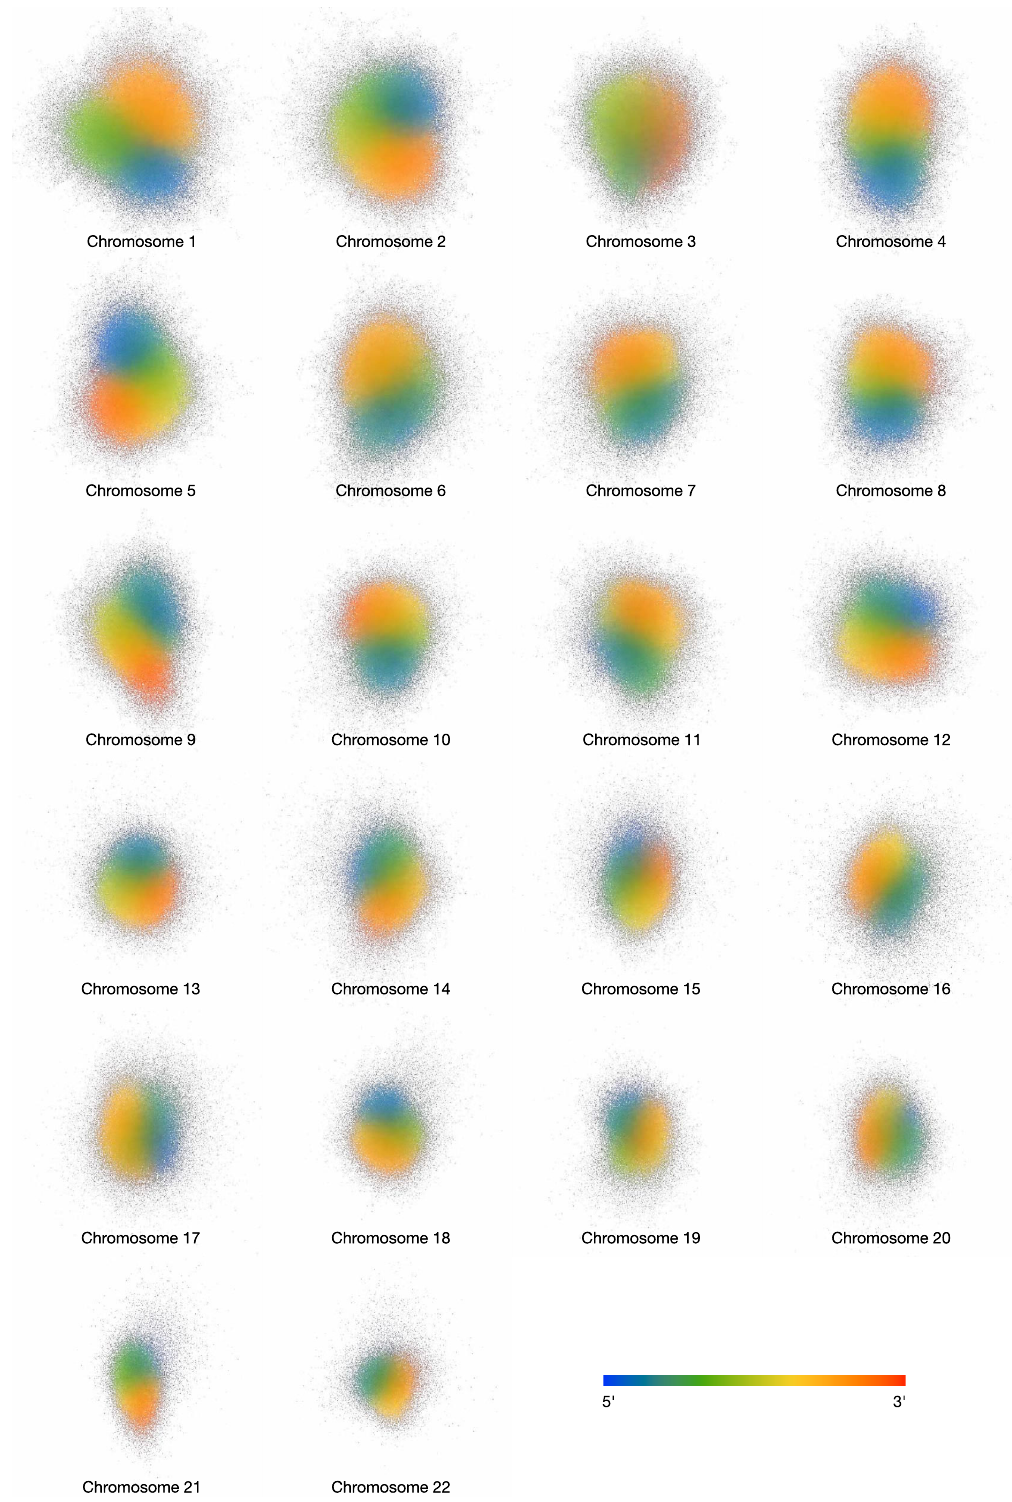
FIG. 13. Superposition of an ensemble of 3D structures for all 23 chromosomes. A total number of 1000 conformations are aligned and superimposed for each chromosome. Each point represents one locus from a single conformation, with color representing the genomic location of the locus along the